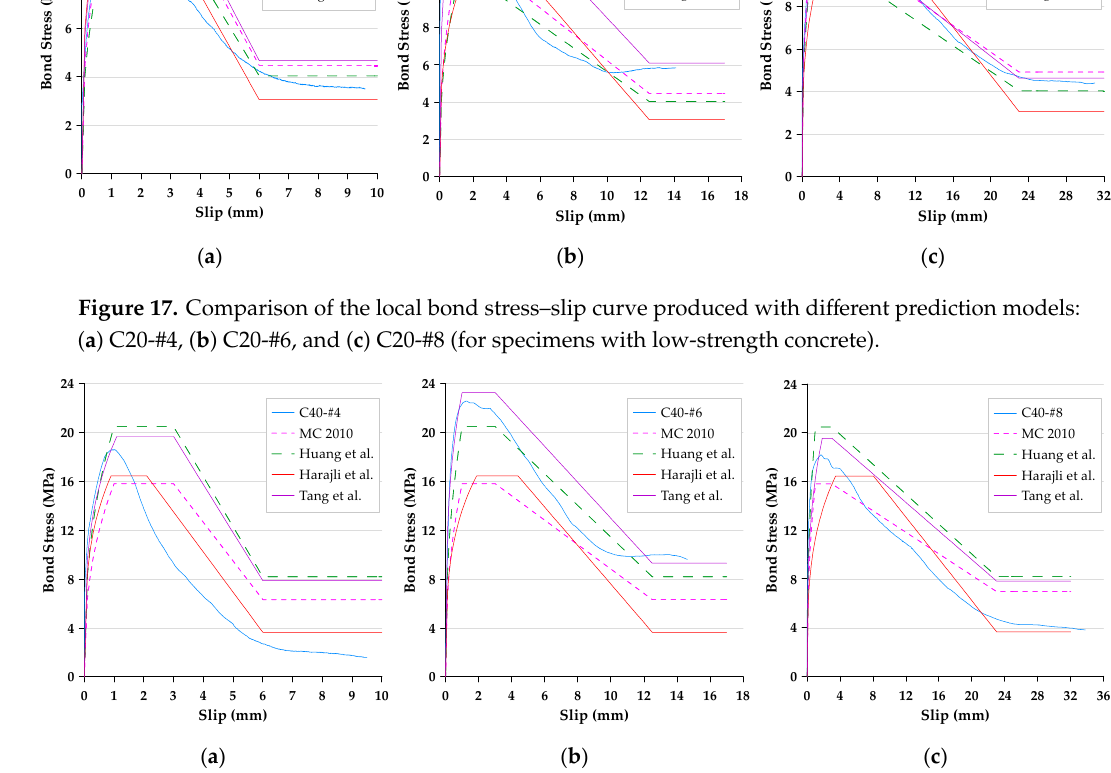
Figure 18. Comparison of the local bond stress–slip curve produced with different prediction models: ( a ) C40-#4, ( b ) C40-#6, and ( c ) C40-#8 (for specimens with medium-strength concrete).